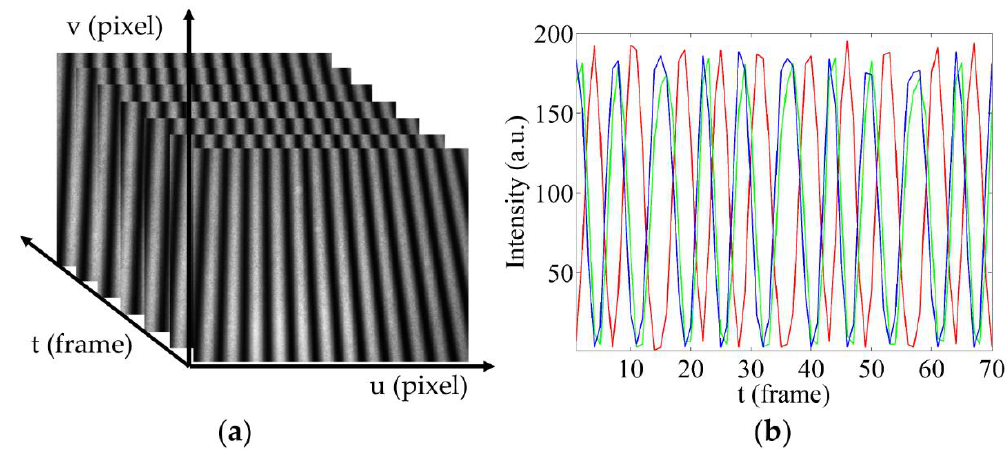
Figure 10. Deformed fringe patterns. ( a ) A sequence of deformed fringe pattern captured by the camera. ( b ) Intensity distribution along the temporal axis.